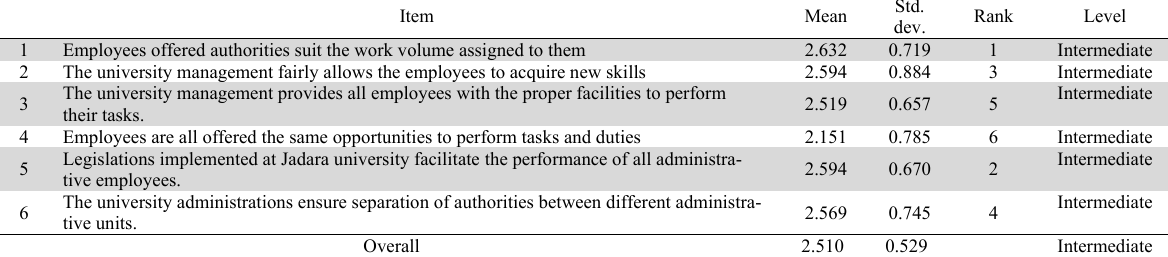
The mean and standard deviation of the factors associated with empowerment Item Mean